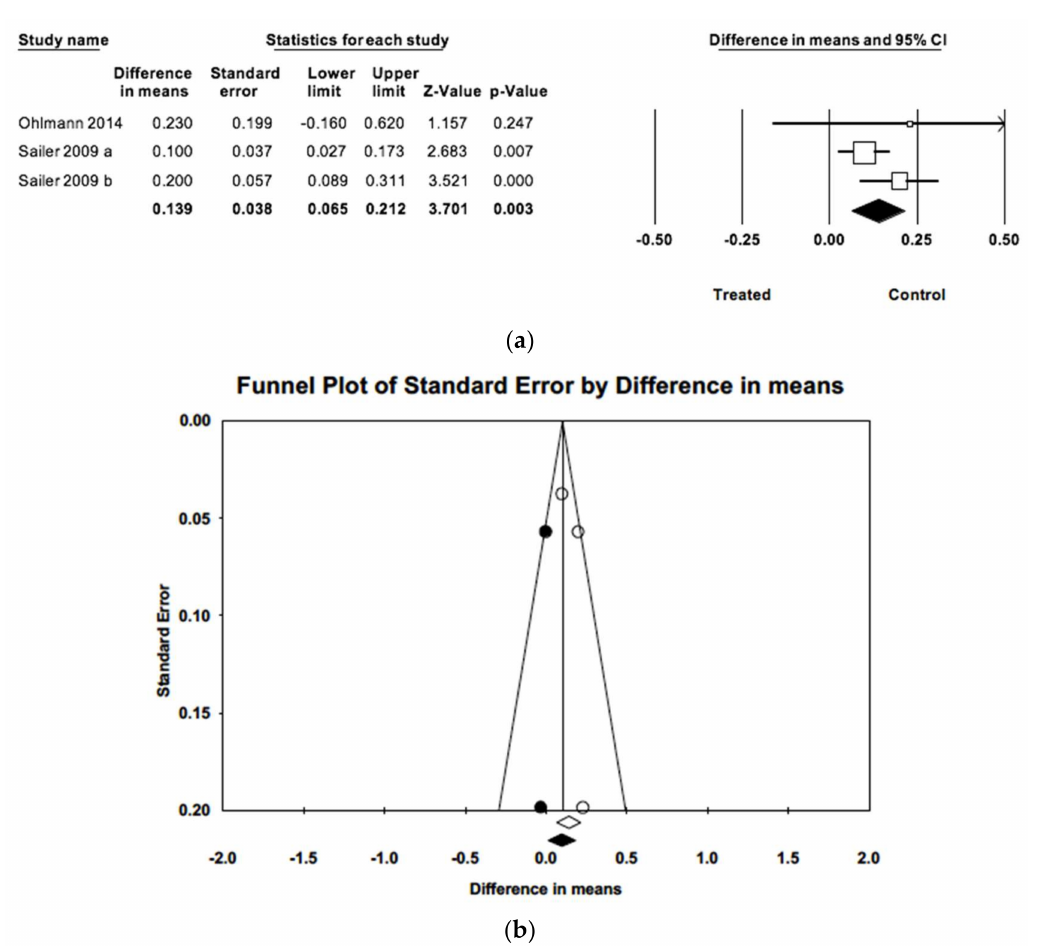
Figure 3. ( a ) Forest plot of meta-analysis of the di ff erence in mean gingival indices between treated and control samples. ( b ) Funnel plot of observed and imputed